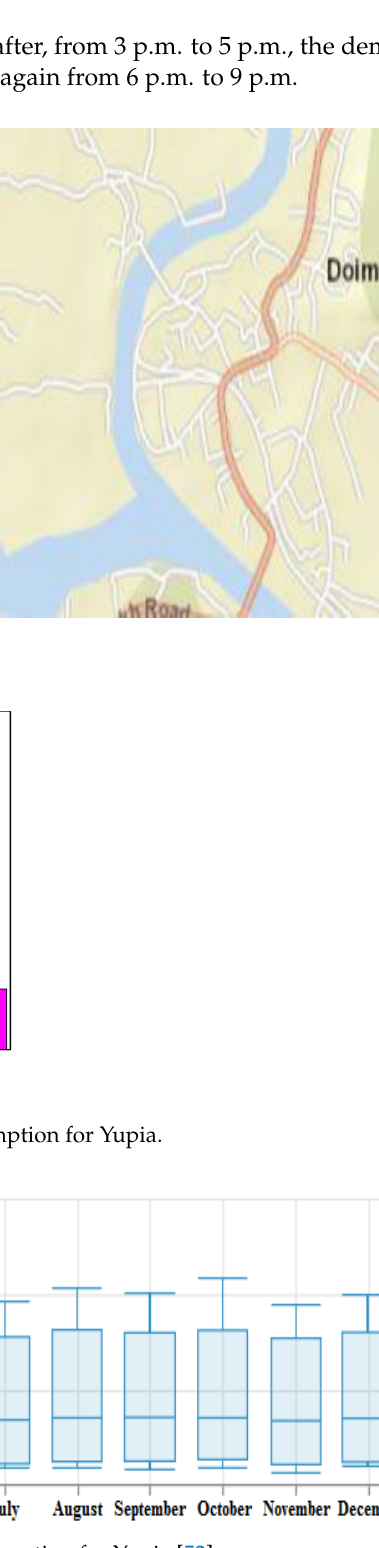
Figure 3. Hourly distribution profile of the load consumption for Yupia.